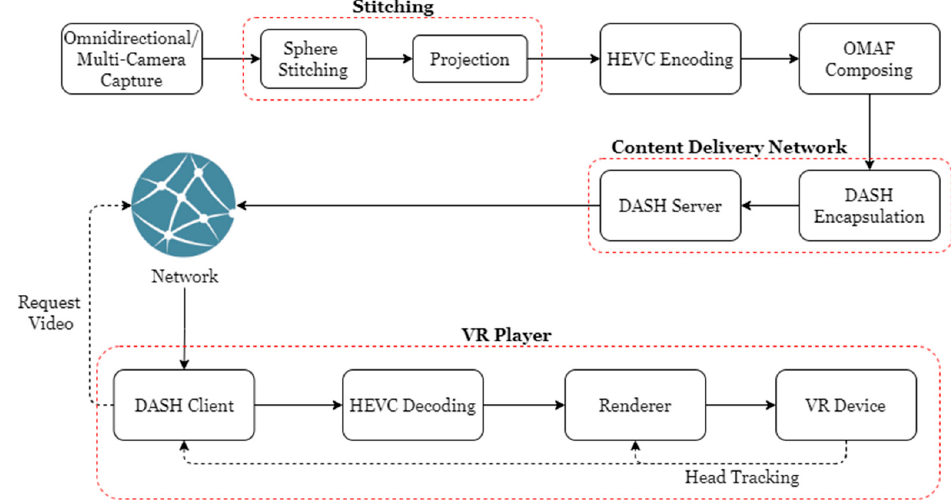
Figure 3. DASH-OMAF architecture network.